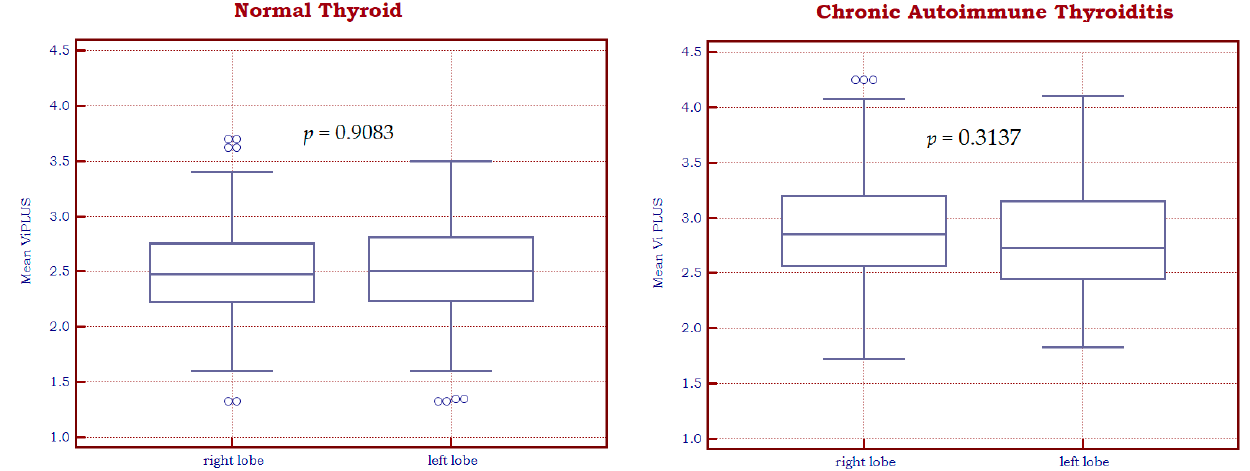
Figure 4. Box-and-whisker distribution plots representing Vi PLUS values of the left and right thyroid lobes for normal thyroid tissue ( left ) and autoimmune thyroiditis ( right ).